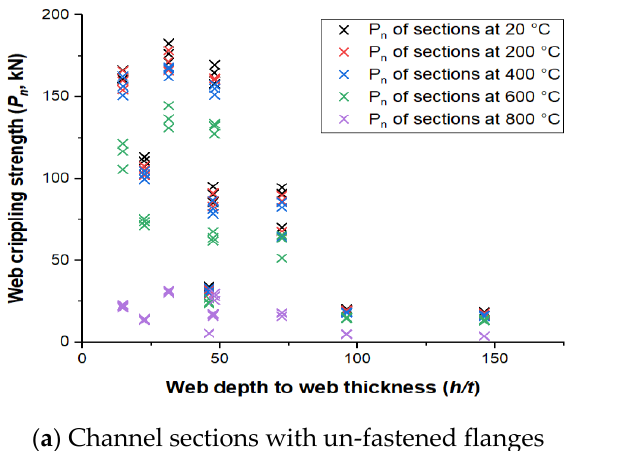
Figure 11. Ratio of h/t against web crippling strength.